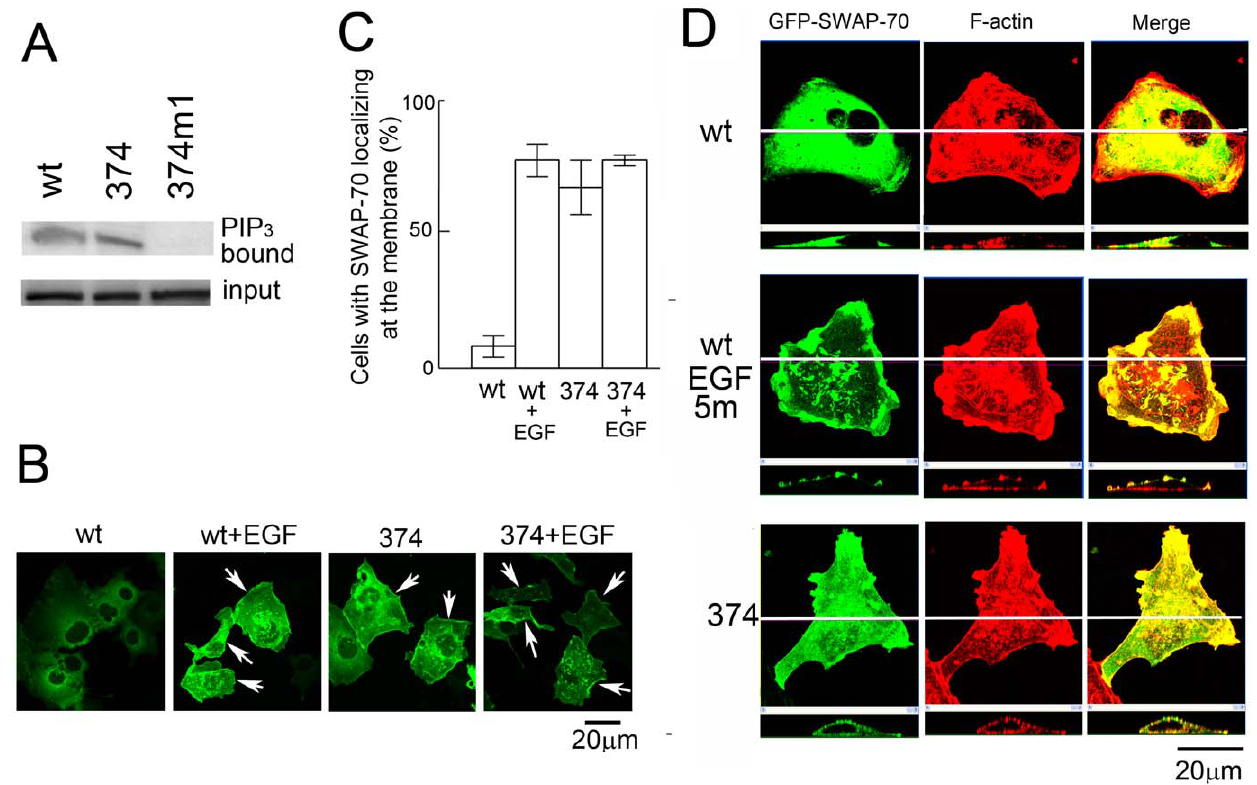
Figure 1. A mutant SWAP-70, SWAP-70-374, locates at the plasma membrane. A, Binding activities of the mutant SWAP-70s to PtdIns(3,4,5)P 3 were analyzed using the bead binding assay. The upper panel shows SWAP-70s bound to the beads and the lower panel shows the protein used for the assay. B, Expression vectors for the wild-type while the mutant SWAP-70 were introduced into Cos7 cells and the localization of expressed proteins was analyzed by confocal microscopy. The stacked images are shown. The arrows indicate the cells whose SWAP-70 were found at the plasma membrane. C, The percentages of the cells whose GFP-SWAP-70s were found at the plasma membrane are shown. Experiments were repeated three times and the means are shown in the graph. The error bars show standard deviation. D, Expression vectors for GFP-SWAP-70 or GFP- SWAP-70-374 were introduced into Cos7 cells by eletroporation. The cells expressing GFP-SWAP-70 were stimulated with EGF (100 ng/ml) for 5 min. After fixation with formaldehyde, cells were stained with TRITC-phalloidin and observed using confocal microscopy. The upper panels show XY images of the cells and the lower XZ images. The lines in the top panels show the place where XZ images were made.